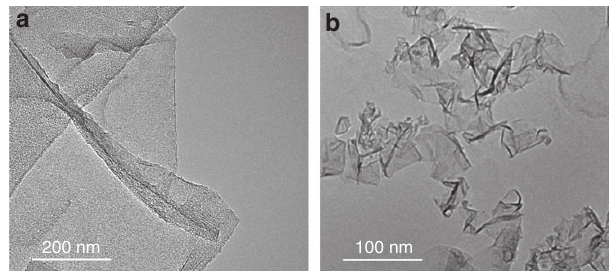
Figure 2 | Transmission electron microscopy. Transmission electron microscopy images of ( a ) single-layer graphene flakes from ethanol based (GEth) and ( b ) few-layer graphene flakes from water based inks (GW).